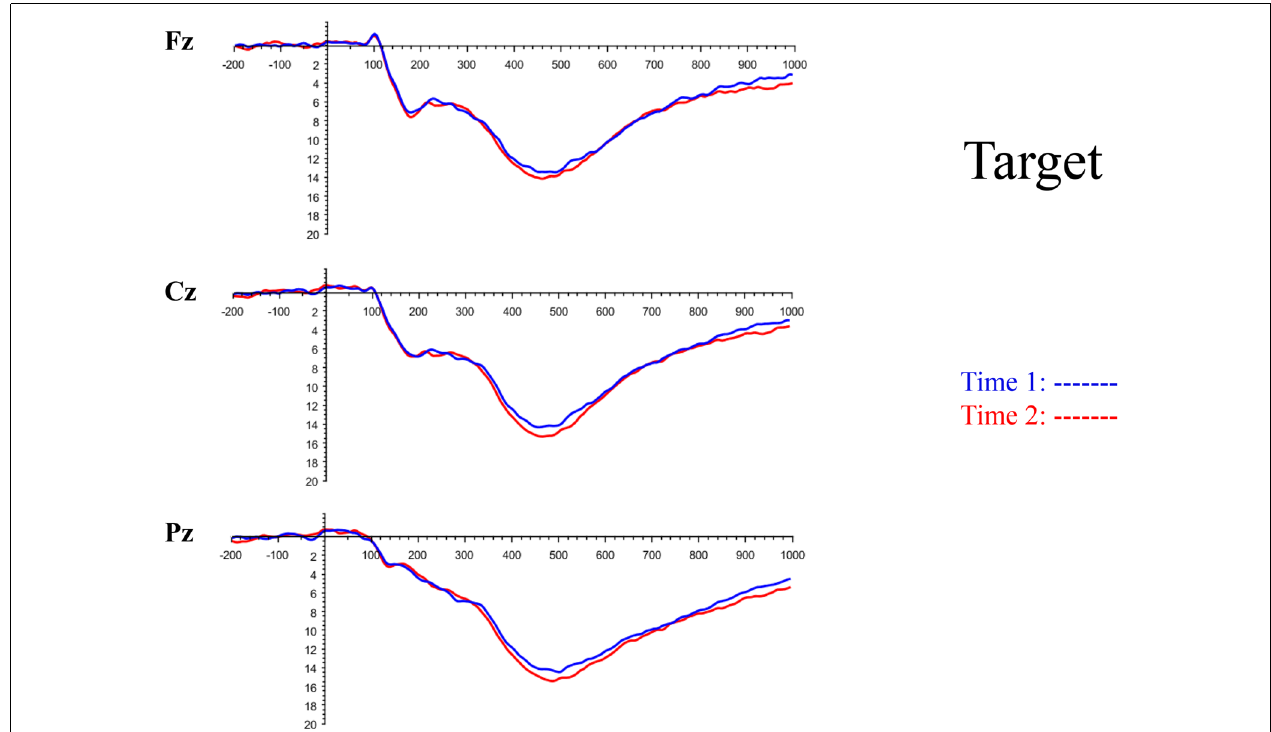
FIGURE 7 | Grand average ERP plots in response to target stimuli at Fz, Cz, and Pz at Time-1 and Time-2.